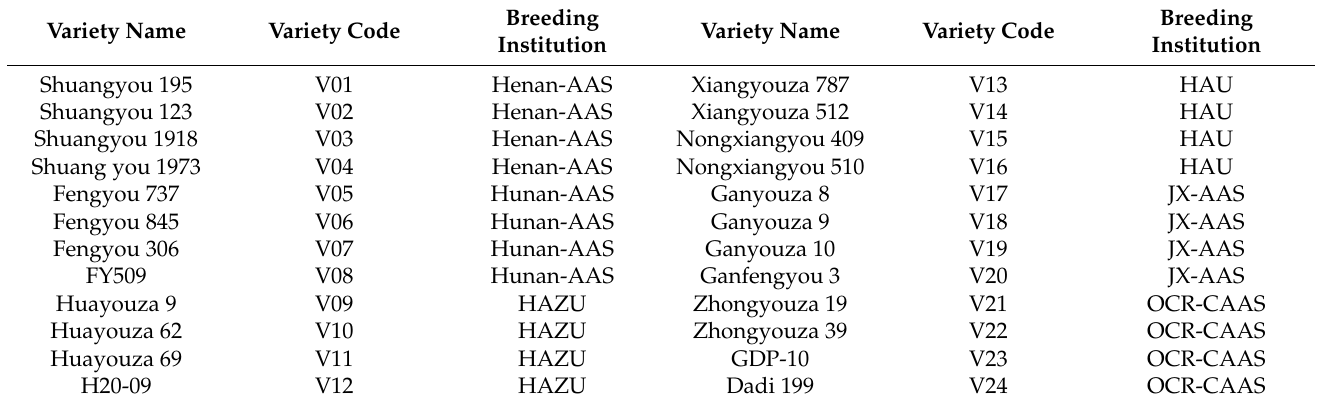
Table 1. Information on 24 hybrid rapeseed varieties used in the